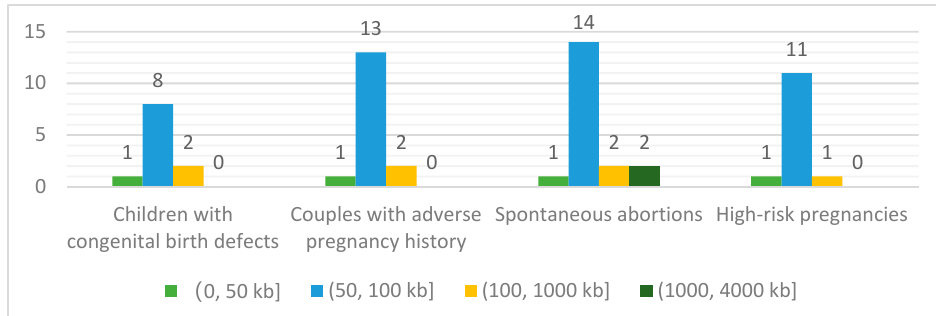
Figure 3. Detection limit for CNV size detection (resolution) of low-pass WGS-based CNV analysis for different patients among 21 Chinese tertiary hospitals in this survey. The green, blue, orange, and dark-green bars show the number of hospitals reporting their resolution within the (0, 50 kb], (50, 100 kb], (100, 1000 kb], (1000, 4000 kb] range across different indications of referral.